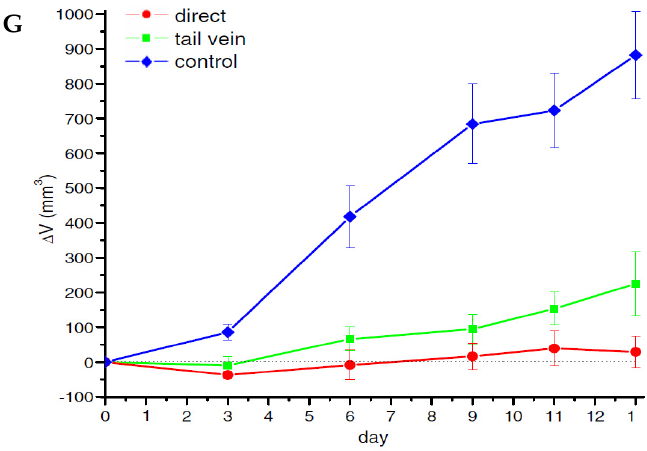
Figure 2. PPTT using passive targeting AuNRs. ( A ) Blood circulation for targeted and nontargeted AuNRs in healthy mice models. ( B ) Organ uptake of targeted and nontargeted AuNRs in healthy mice models at 24 h postinjection in A549 xenografted mice models. ( C ) Tumor uptake of targeted and nontargeted AuNRs at 24 h postinjection in A549 lung cancer xenografted mice models. AuNRs were quantified by ICP-MS in ( A − C ). ( D ) NIR transmission image of HSC-3 head and neck xenografted mice showing AuNRs in tumor for the intravenously and intratumoral administrated mice. ( E − F ) Thermal transient measurement of HSC-3 tumor interstitial during direct ( E ) and intravenous ( F ) NIR PPTT in comparison to sham/NIR treatment without PEGylated AuNRs. ( G ) Average change in tumor volume for HSC-3 xenografted mice following NIR PPTT by control (blue), intravenous (blue), and direct (red) injection of PEGylated AuNRs. ( A − C ) Reprinted/adapted with permission from Ref [61]. Copyright © 2010, American Chemical Society. ( D − G ) Reprinted/adapted from Ref [63]. Copyright © 2008, Elsevier.